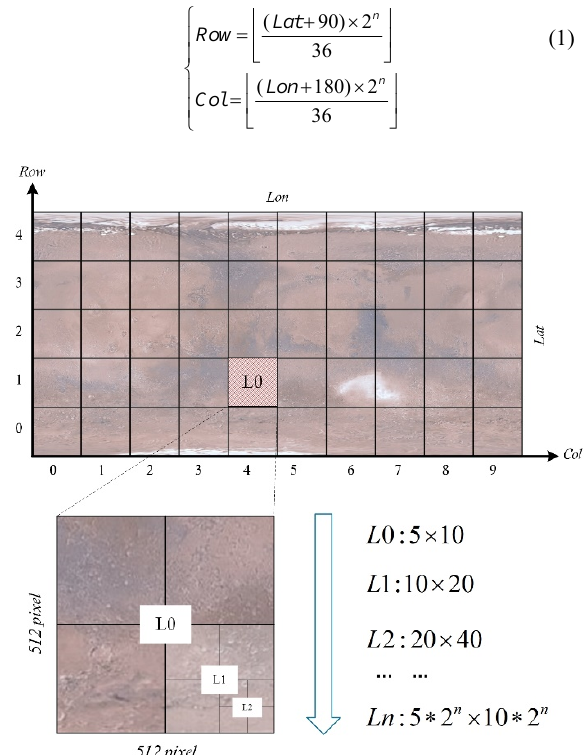
Figure 3. Geographic data segmentation and index method